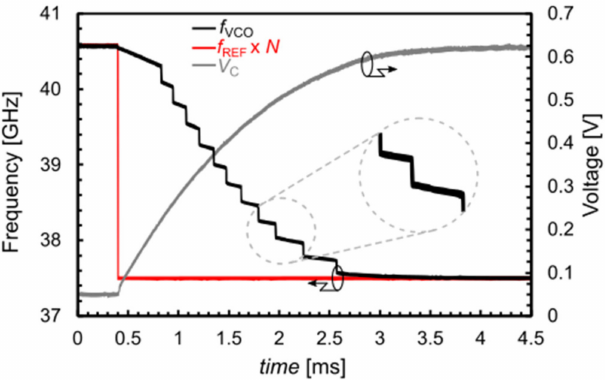
Figure 9. Transient response of the VCO oscillation frequency with 20-kHz PLL